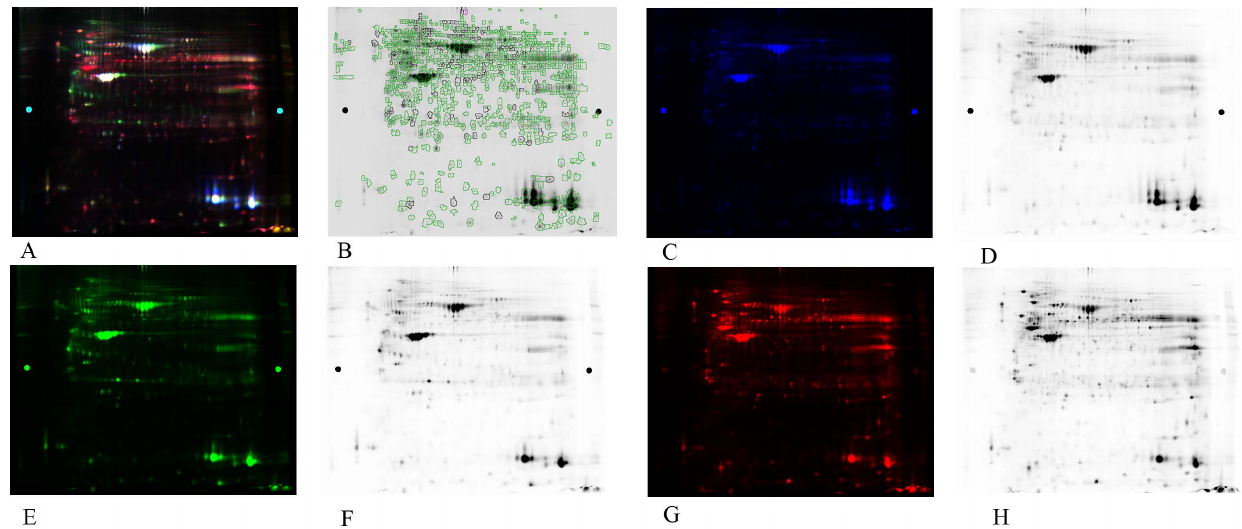
Figure 1. Representative 2D-DIGE proteome map of lung cancer tissue samples vs. benign tissue samples. (A) Representative 2D-DIGE gel images. The extracted proteins were labeled with fluorescent dyes and separated by 2D-DIGE. (B) A representative two-dimensional gel image. A total of 1065 differentially expressed protein spots successfully identified by MALDI-TOF-MS are circled. (C) and (D): a mixture of all protein samples as the internal standard stained with Cy2 (blue). (E) and (F): adjacent normal tissues stained by Cy3 (green). (G) and (H): SCC tissues stained by Cy5 (red).